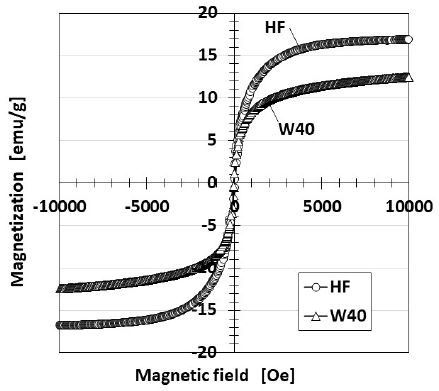
Figure 2. Magnetization of HF.